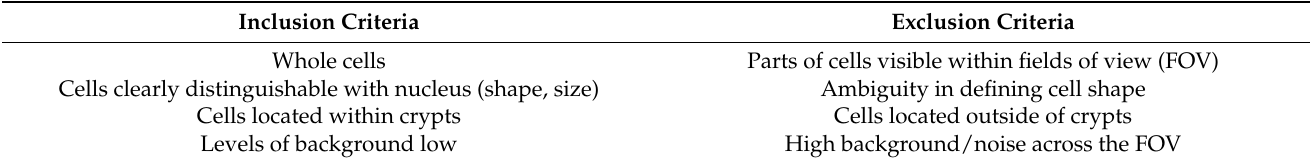
Table 1. Inclusion and exclusion criteria for counting of stained